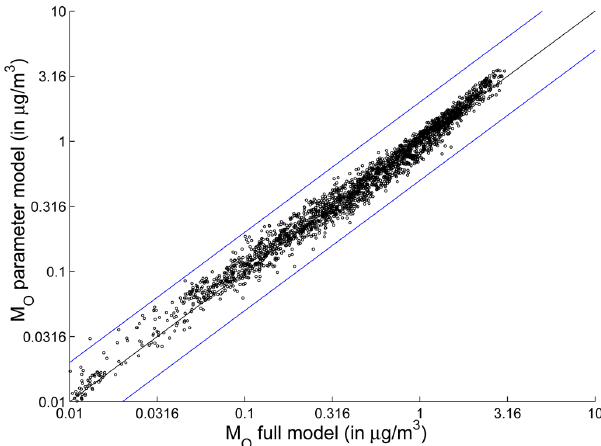
Fig. 10. Daily averaged α -pinene M O parameter model values ver- sus full BOREAM model values for 17 locations during 5 months, using ambient data simulated with the global CTM IMAGESv2. The blue lines indicate the region of agreement to within a factor